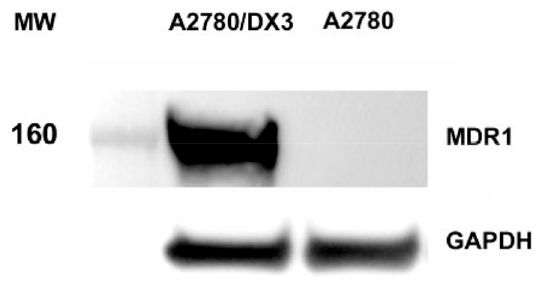
Figure 4. Differential expression of ABCB1 in sensitive A2780 and multidrug resistant A2780/DX3 cells. The flow cytometric analysis results for the reversing activity of compounds 6 and 7 , in resistant A2780/DX3 cells, are summarized in Table 4. Table 4. Percent doxorubicin accumulation in multidrug resistant A2780 / DX3 cells after co-treatment with compounds 6 and 7